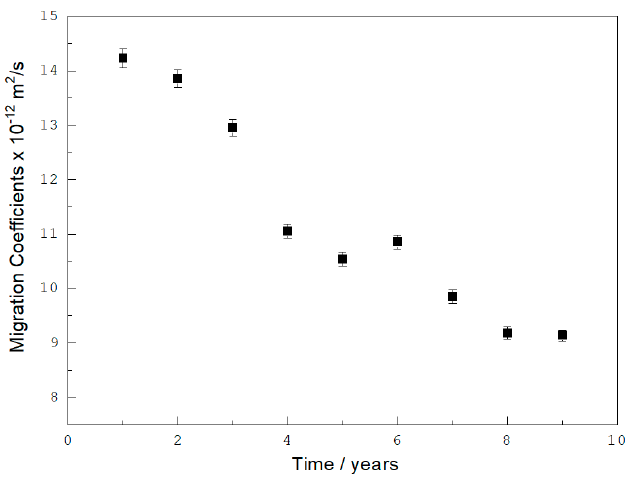
Figure 8. Non-steady-state migration coefficient as a function of time.